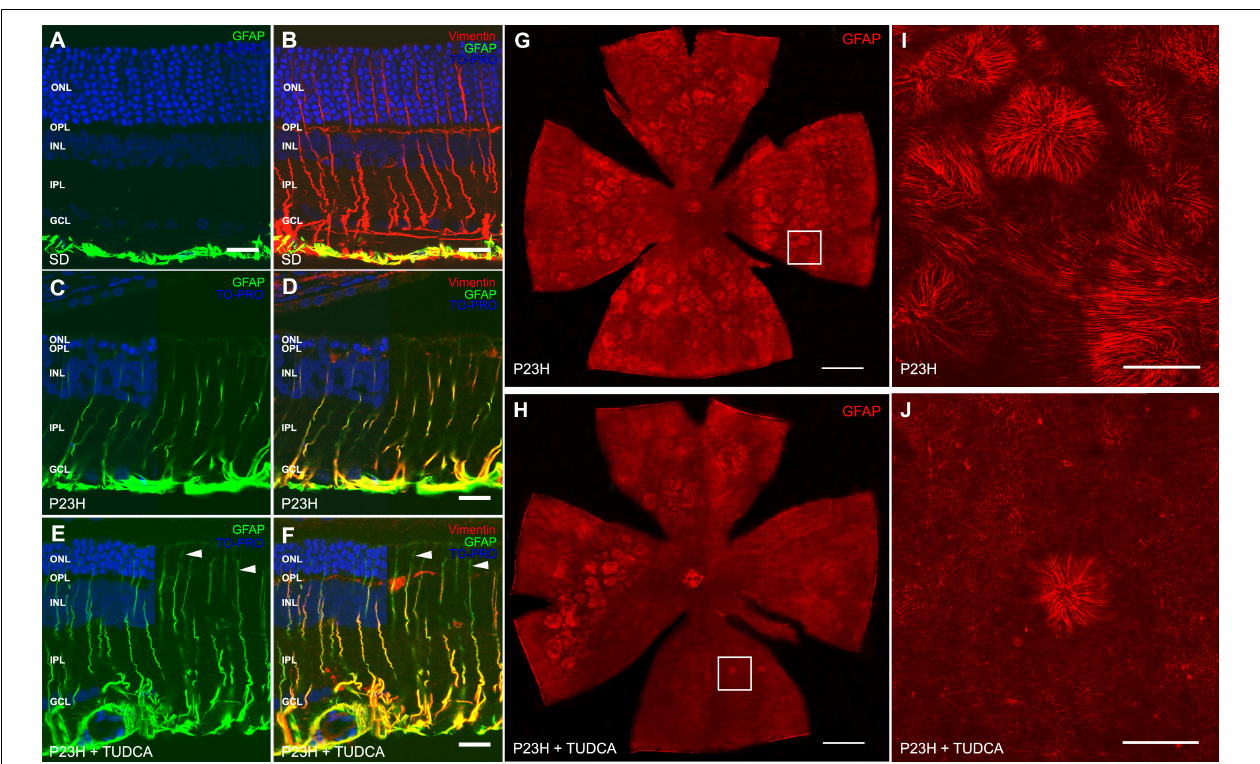
FIGURE 5 | Tauroursodeoxicholic acid (TUDCA) effects on Müller cell gliotic changes in P23H rats. (A–F) Retinal cross-sections from an SD (A,B) , P23H (C,D) , and TUDCA-treated P23H (E,F) rat at P120, immunostained against GFAP (green) and vimentin (red). TO-PRO 3 iodide was used to visualize the nuclei (blue). All images were collected from the medial retina. Note the increased immunoreactivity against GFAP in Müller cells from dystrophic retinas, indicating reactive gliosis. No remarkable effects of TUDCA are observed. (G,H) Whole mount retinas from a vehicle-treated (G) and TUDCA-treated (H) P23H rat at P120 immunostained against GFAP, showing the distribution of the apical processes of Müller cells in the ONL. Only representative dystrophic rats are included in the figure since only gliotic Müller cells express GFAP. (I,J) High magnification of apical processes of Müller cells at the outer retina. Note the presence of Müller cell processes arranged in clusters forming firework-like structures, more numerous in vehicle-treated than in TUDCA-treated P23H retinas. A minimum of n = 5 animals per group were analyzed. ONL: outer nuclear layer; OPL: outer plexiform layer; INL: inner nuclear layer; IPL: inner plexiform layer; GCL: ganglion cell layer. Scale bar: 20 µ m (A–F) , 1 mm (G,H) , 200 µ m (I,J)